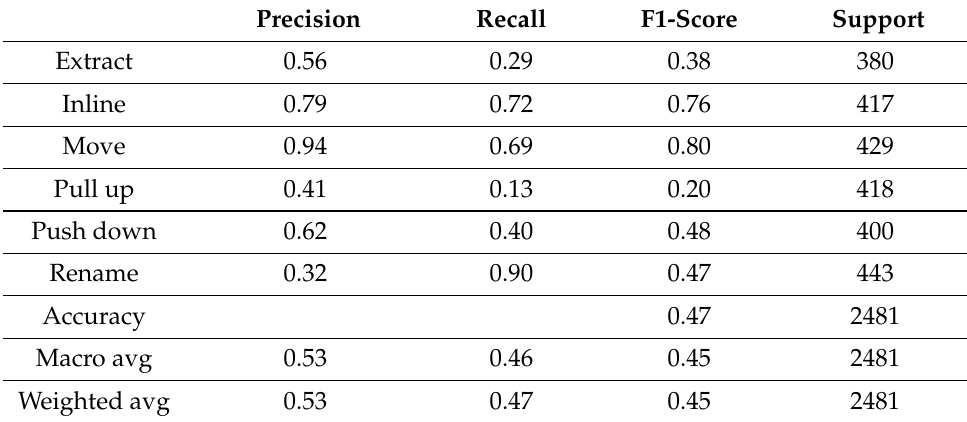
Table 8. Results of Logistic Regression model.